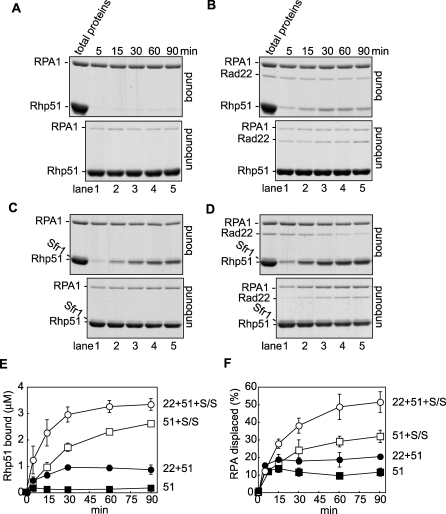
Time Course of Rhp51 Loading and RPA DisplacementRPA-saturated css beads were prepared by incubating immobilized ssDNA with RPA and then removing excess RPA by washing the beads with a buffer. Protein mixtures containing Rhp51 (5 μM) were incubated with RPA-saturated ssDNA (approximately 10 μM nucleotide) in a final volume of 80 μl at time 0. Aliquots (12 μl) were taken at various time points, and the css beads were immediately pulled down. The bound and unbound fractions were analyzed by SDS-PAGE. The following proteins were incubated with RPA-saturated css beads: (A) Rhp51 (5 μM) alone; (B) Rhp51 (5 μM) and Rad22 (0.5 μM); (C) Rhp51 (5 μM) and Swi5-Sfr1 (0.5 μM); and (D) Rhp51 (5 μM), Rad22 (0.5 μM), and Swi5-Sfr1(0.5 μM).The graphs show the amount of Rhp51 (μM) in the bound fractions (E) and the relative amounts of RPA (%) in the unbound fractions (F). The values and error bars in the graphs are average percentages and s.d., respectively, obtained from three independent experiments. 22, Rad22; 51, Rhp51; S/S, Swi5-Sfr1.